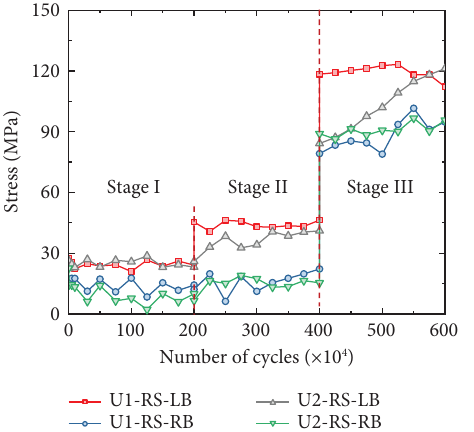
Figure 14: Variation laws of bending strains in headed